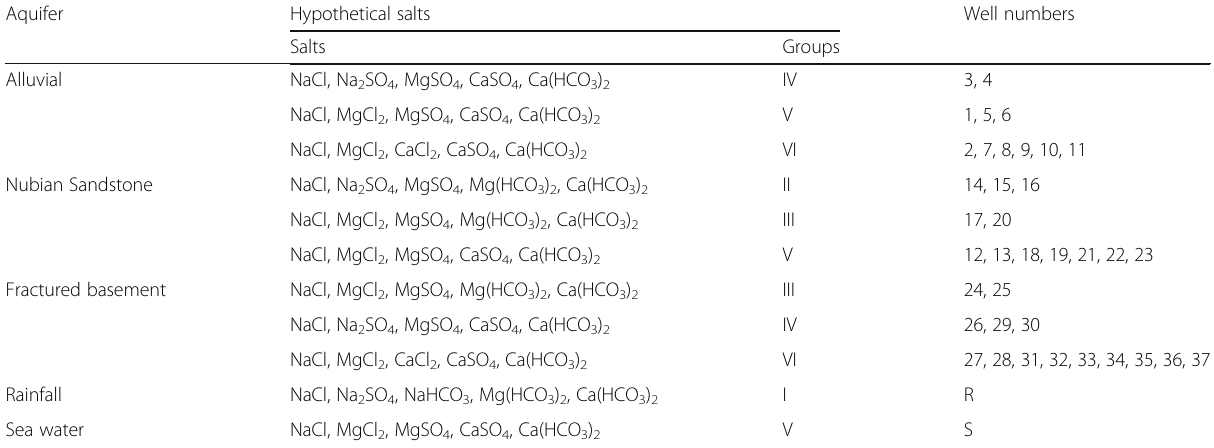
Table 4 Groups of hypothetical salts for the studied groundwater samples Aquifer Hypothetical salts Well numbers Salts Groups